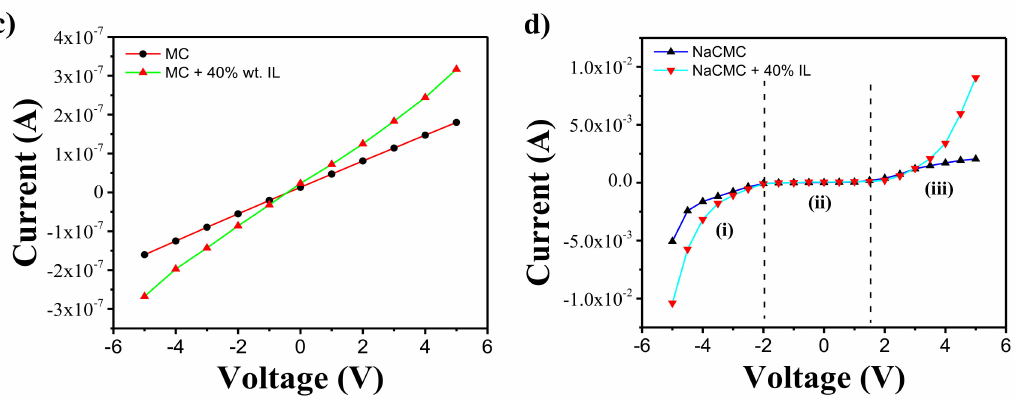
Figure 6. Representative current-voltage (I–V) curves for ( a ) neat CNC and CNC / [Ch][DHP] composite films with di ff erent IL contents (10, 25 and 40% wt.), ( b ) neat HPC and HPC + 40% wt. IL, ( c ) neat MC and MC + 40% wt. IL and ( d ) neat NaCMC and NaCMC + 40% wt. IL.